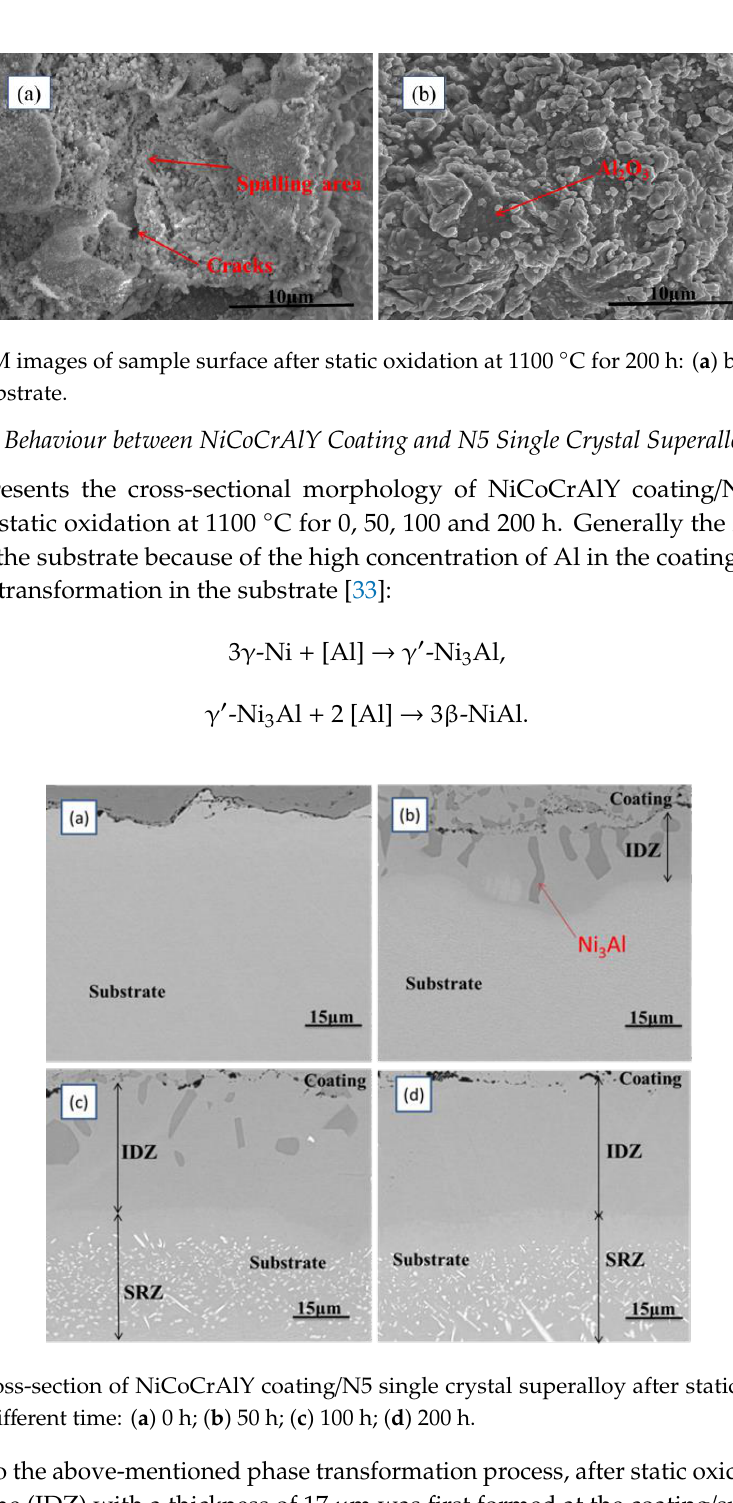
Figure 3. SEM images of sample surface after static oxidation at 1100 °C for 200 h: ( a ) bare substrate; ( b ) coated substrate.